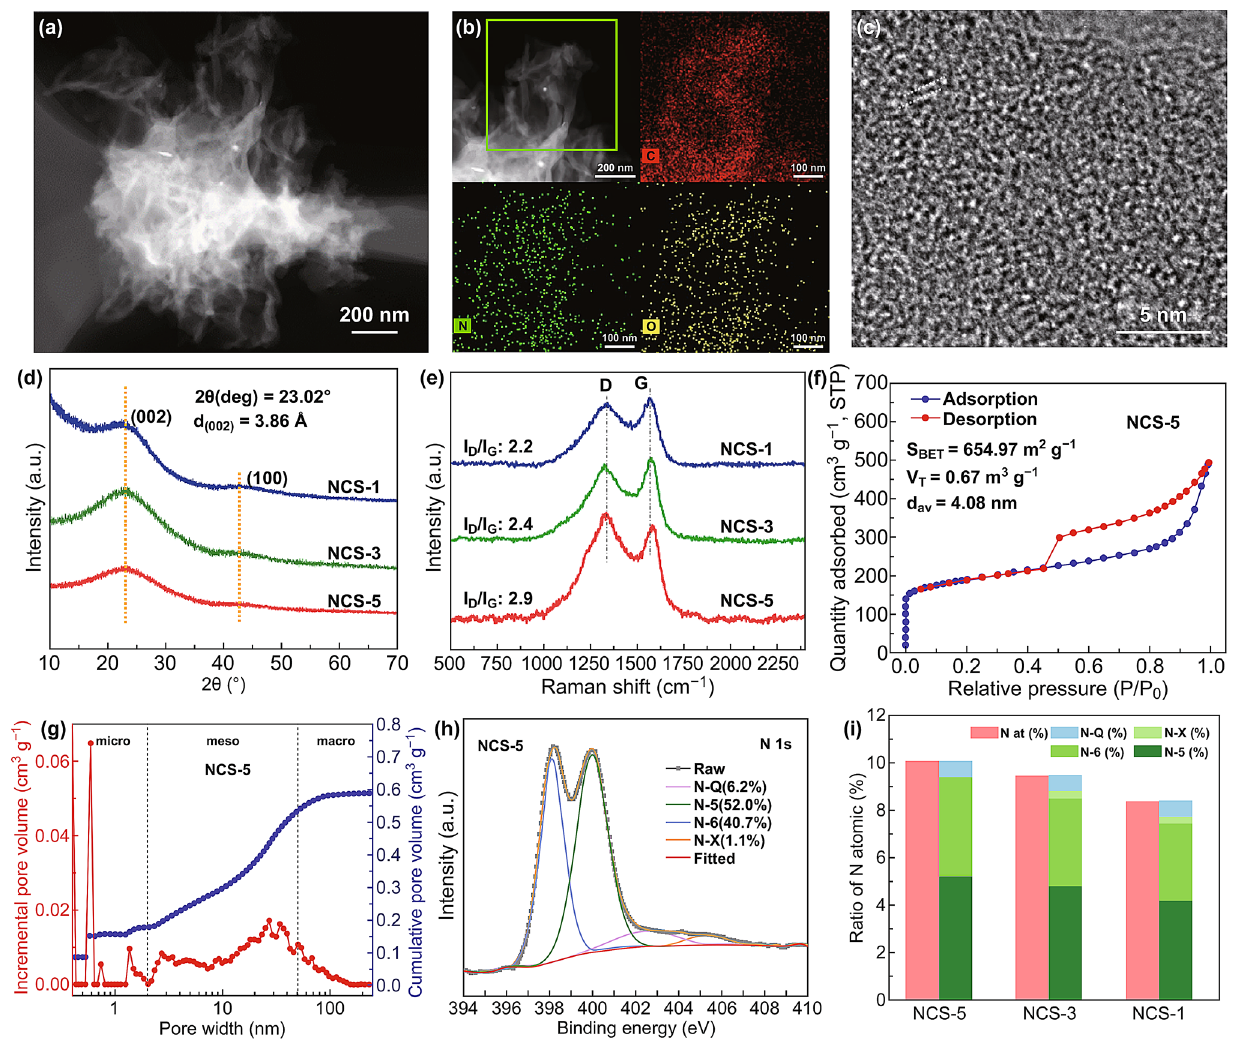
Fig. 3 Structural and compositional characterization of selected NCSs. ( a ) HAADF image of NCS-5. ( b ) HAADF image and corresponding EDS elemental mapping of NCS-5. ( c ) HRTEM image of NCS-5. ( d ) XRD patterns of NCSs. ( e ) Raman spectra NCSs. ( f ) Nitrogen adsorp- tion–desorption isotherms of NCS-5. ( g ) Pore size distribution of NCS-5. ( h ) High-resolution N 1s spectra of NCSs. ( i ) Distributions of different types of N-doping in selected